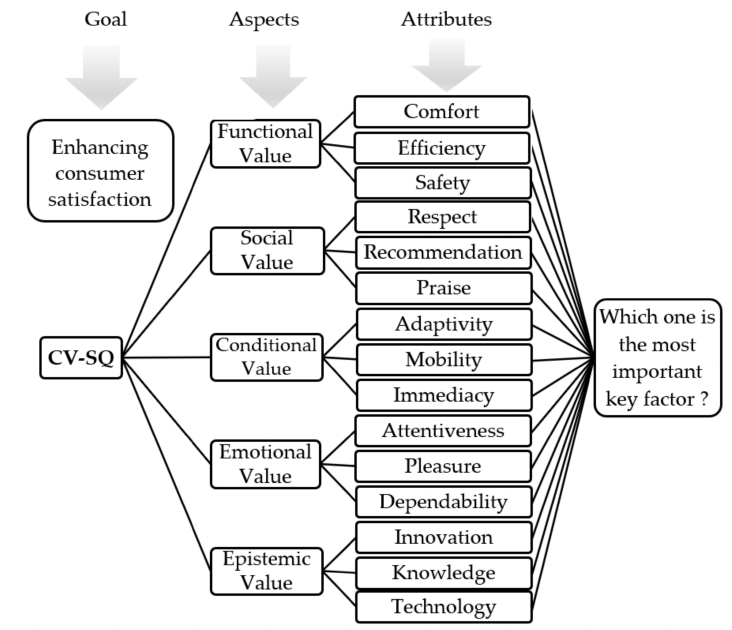
Figure 2. CV-SQ: Theory of consumption values-based service quality